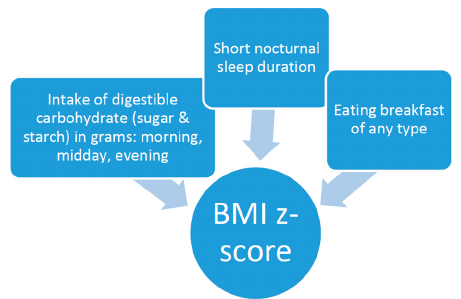
Figure 1. Factors investigated with body mass index (BMI) z-scores. Eating breakfast has a negligible relationship with carbohydrate (sugar and starch) intake during meals. Correlations range from − 0.11 (evening sugar) to 0.13 (morning sugar).